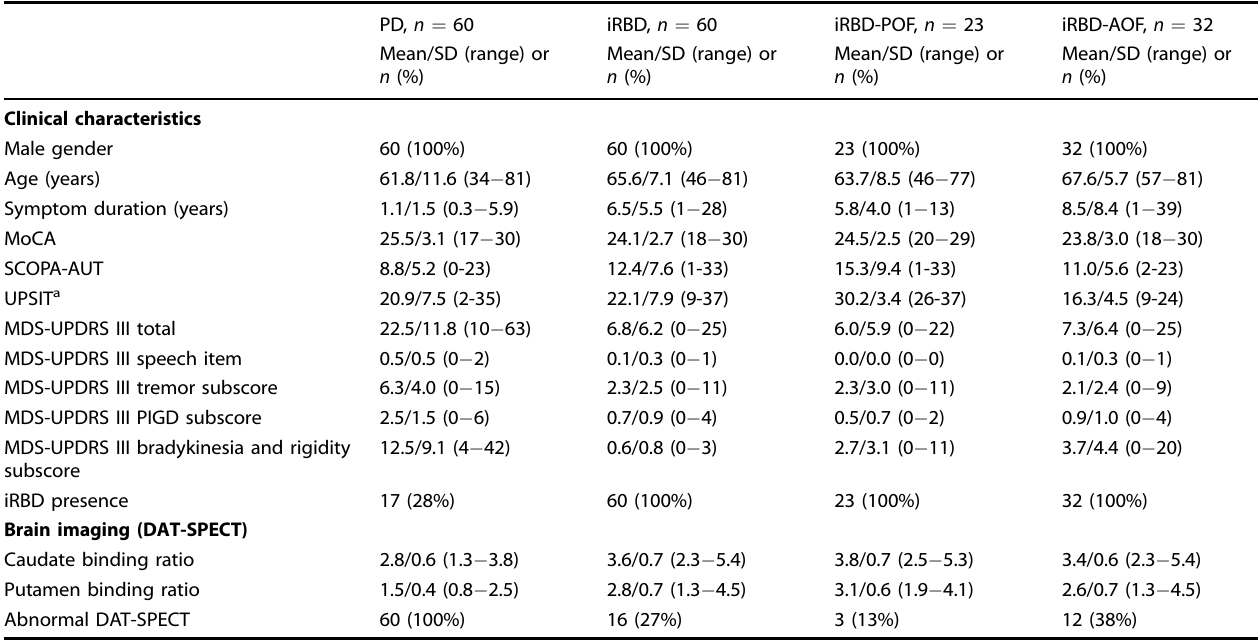
Table 2. Patient clinical and demographic characteristics.